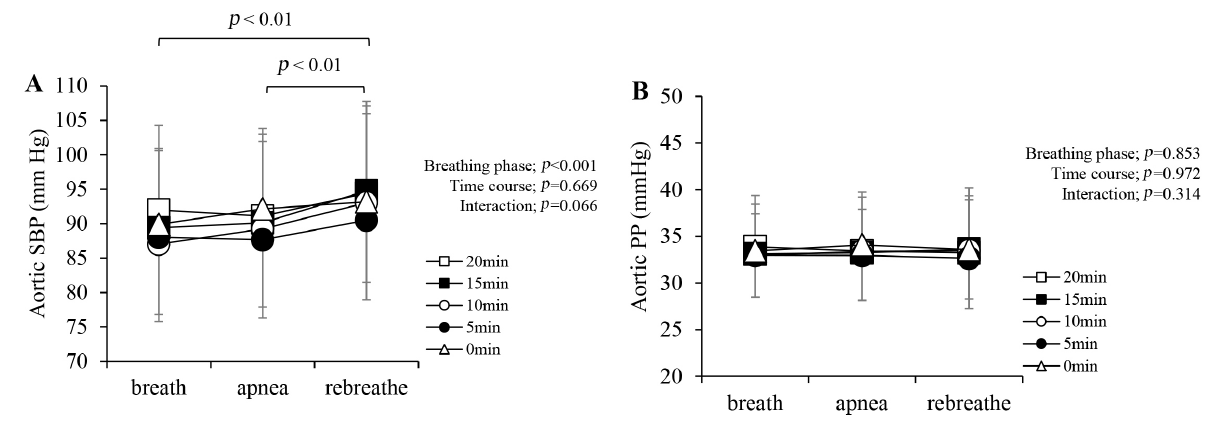
Fig. 2. Response of aortic systolic blood pressure (SBP; A) and aortic pulse pressure (PP; B) at the phase of breath, apnea, and rebreathe during intermittent apnea in 20 min. Error bars represent standard deviations.